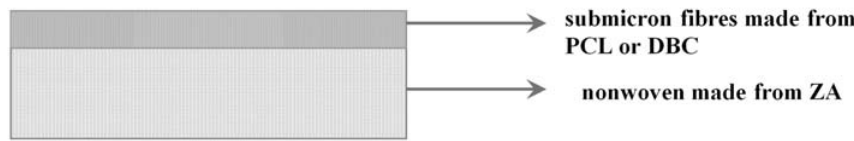
Figure 13. Diagram of variant I